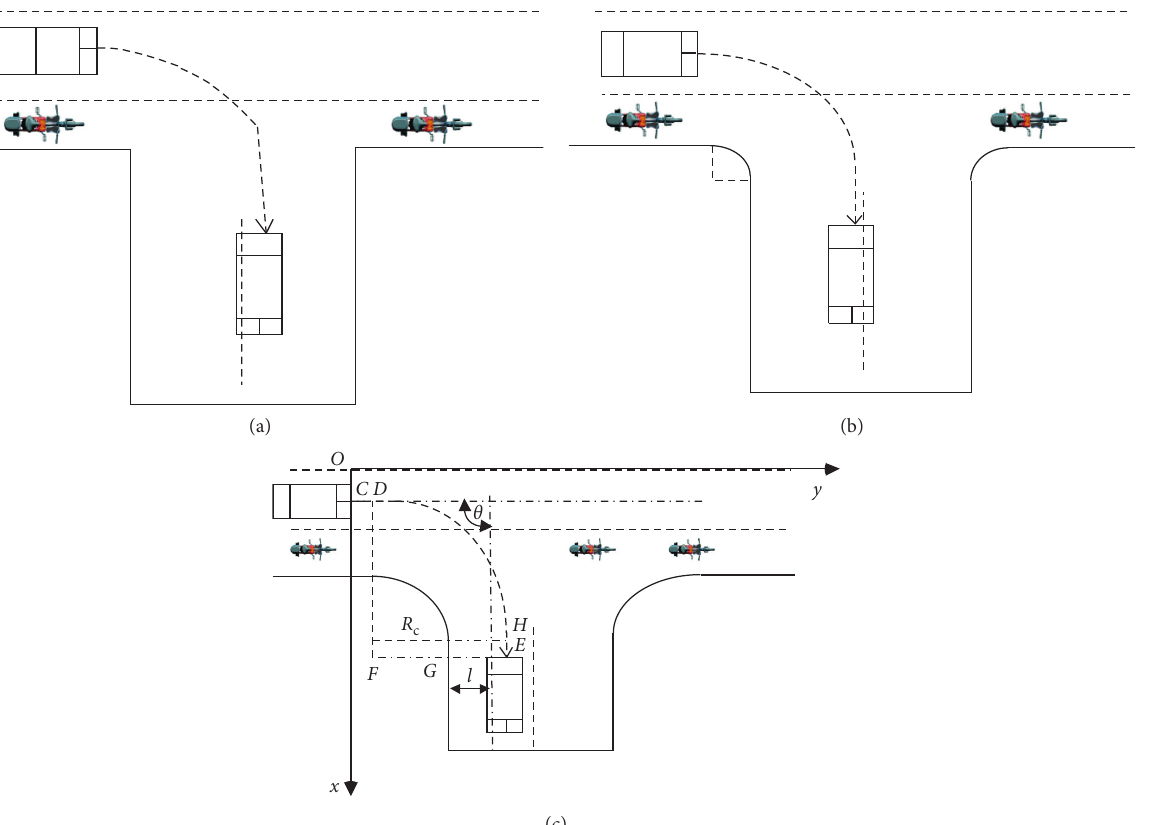
Figure 11: Right turns on the driveway. (a) Driveway without entering radius. (b) Driveway with small entering radius. (c) Driveway with large entering radius.